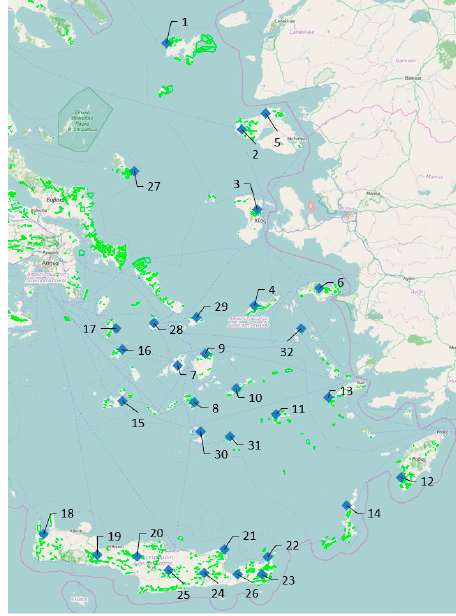
Figure 8. Overview of wind farms applications in the Greek territory with focus on the Aegean islands [27] and selection of representative points in the non-interconnected power systems.